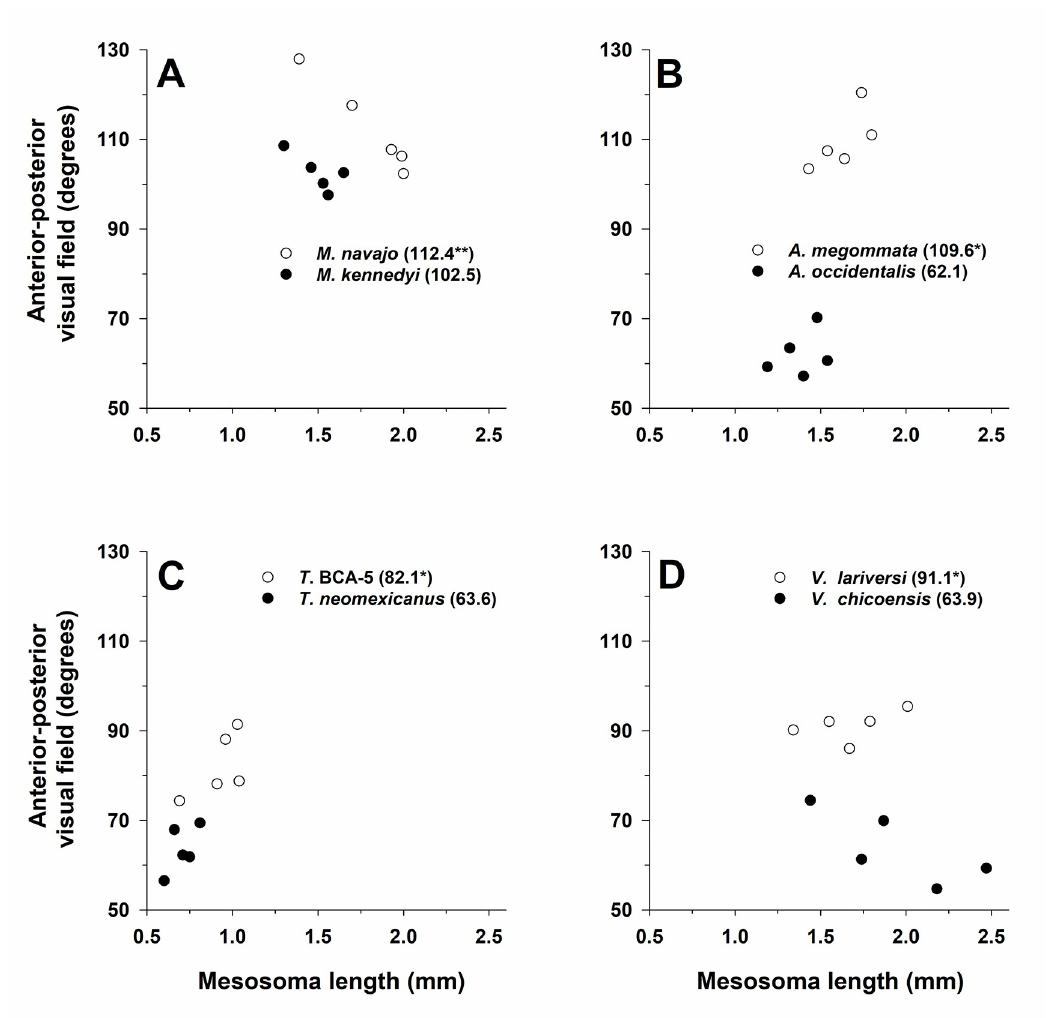
Fig 12. Anterior-posterior visual field span (in degrees) for one pale (open circles and regular font) and one dark (filled circles and bold font) (see text) species in each of four ant genera: ( A ) Myrmecocystus , ( B ) Aphaenogaster , ( C ) Temnothorax , and ( D ) Veromessor . All plots have the same x-axis and y-axis scaling in order to visualize differences between pale and dark species across genera. Mean visual field span (in degrees) is given after each species name with an asterisk denoting the species with a significant larger visual field based on a t-test ( P < 0.05); the double asterisk denotes that the t-test was not significant, but that the visual field was significantly larger when including mesosoma length as a covariate. The significant interaction of genus × activity period is shown by larger differences between pale and dark species of Aphaenogaster compared to those in the other three genera. Sample size is n = 5 for each